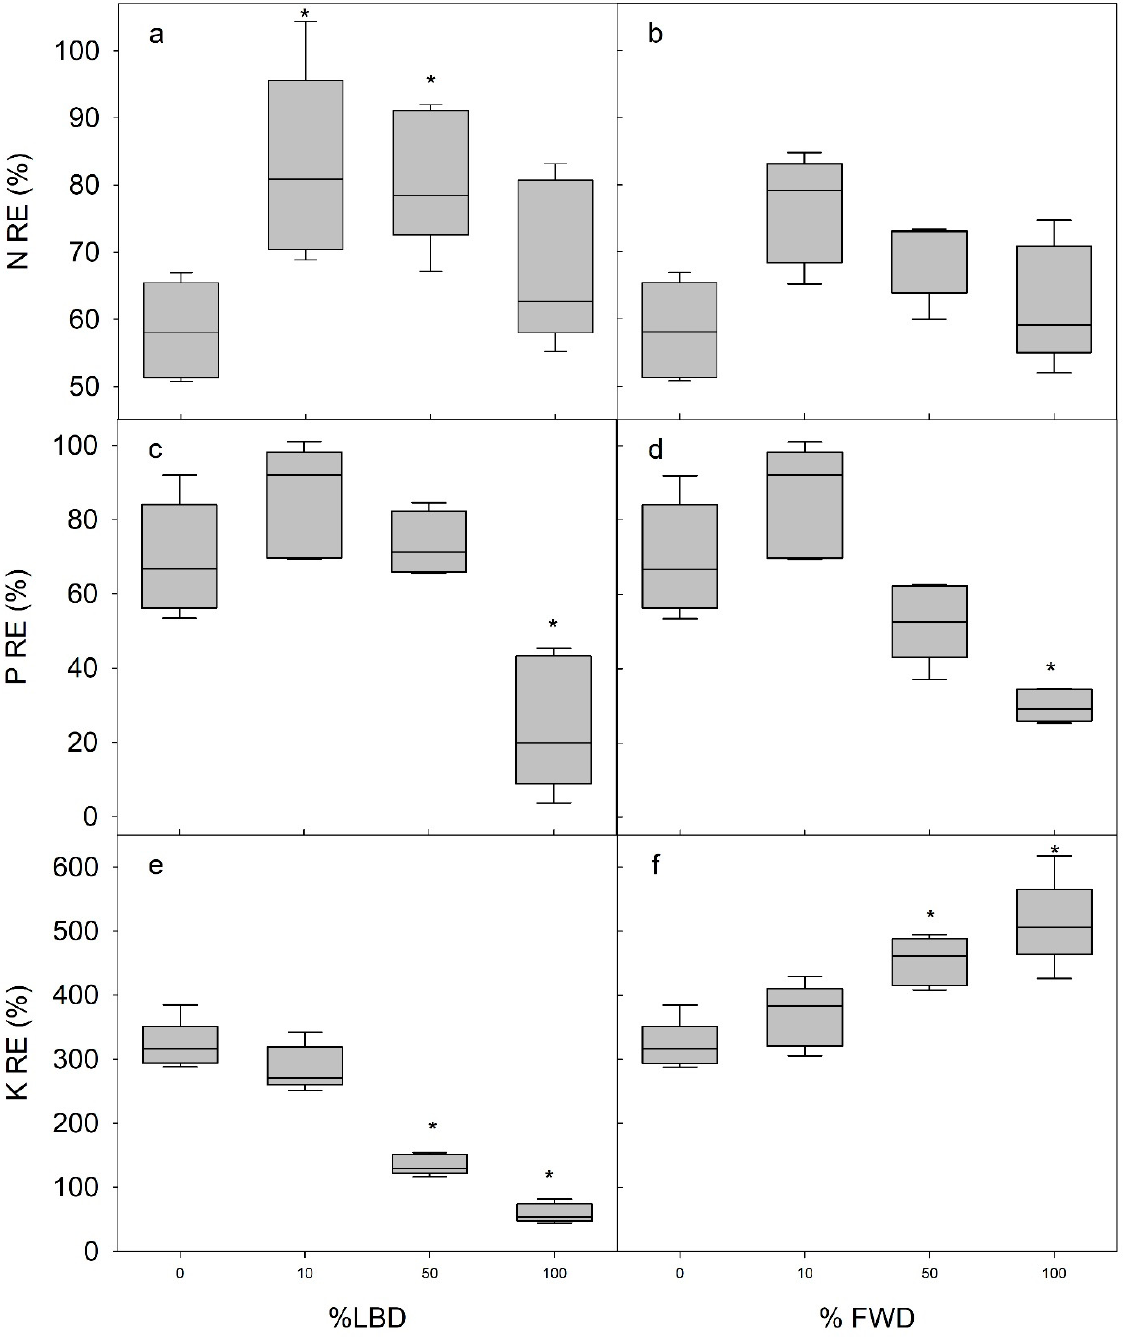
Figure 5. Digestate treatment effects on nitrogen recovery efficiency (RE) for LBD ( a ) and FWD ( b ), phosphorus RE for LBD ( c ) and FWD ( d ) and potassium RE for LBD ( e ) and FWD ( f ). Treatments with an asterisk are significantly different from the fertilizer control ( p < 0.05). Error bars represent the standard error of the mean ( n = 5).